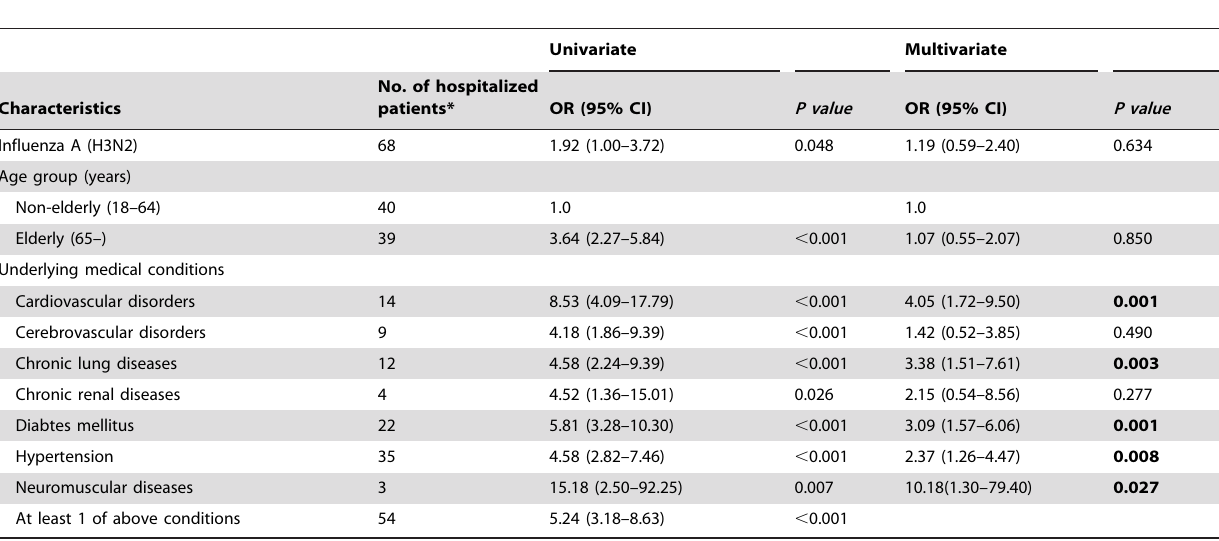
Table 5. Factors associated with hospitalization due to laboratory-confirmed influenza A (H3N2) or B from October 2011 to May